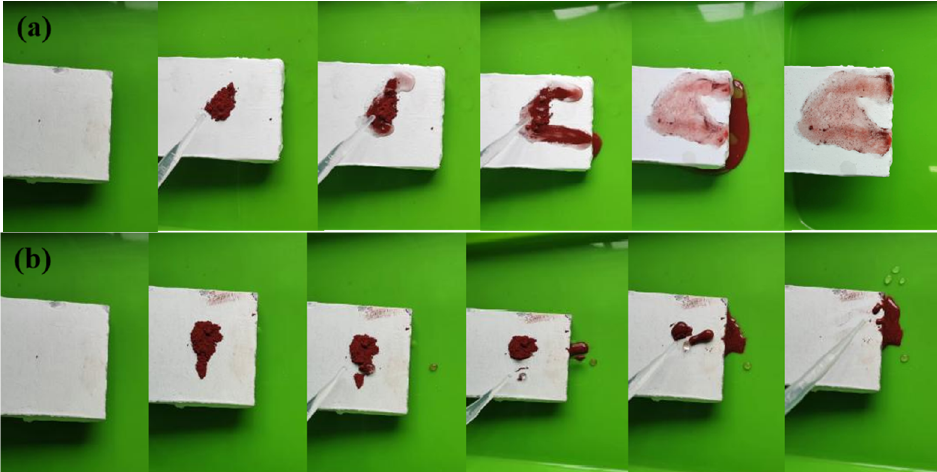
Figure 9. Optical images of particulate contaminants on the surface of building wall samples before and after spraying. ( a ) Particle pollutants contaminate the uncoated wall surface. ( b ) Particle pollutants contaminate the coating with n (PDMS):n (TEOS) = 1:5.